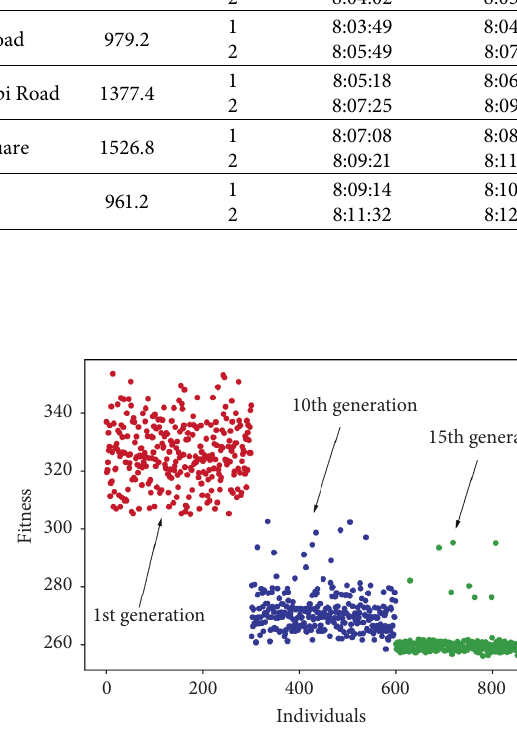
Figure 6: Individuals’ distribution of the 1st, 10th, and 15th generations produced by MGA.